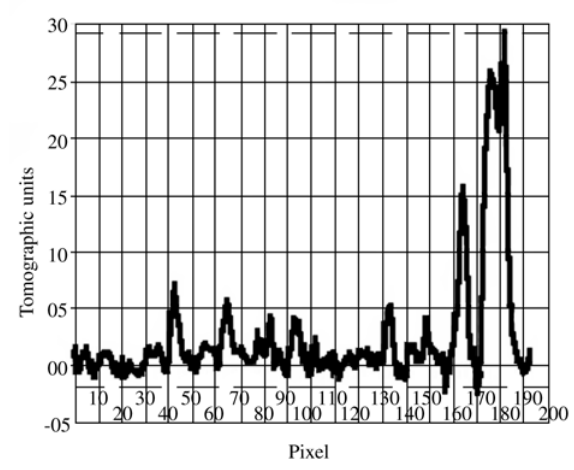
Figure 10. Selected transept of the 75 ppi ceramic sample’s CT image.